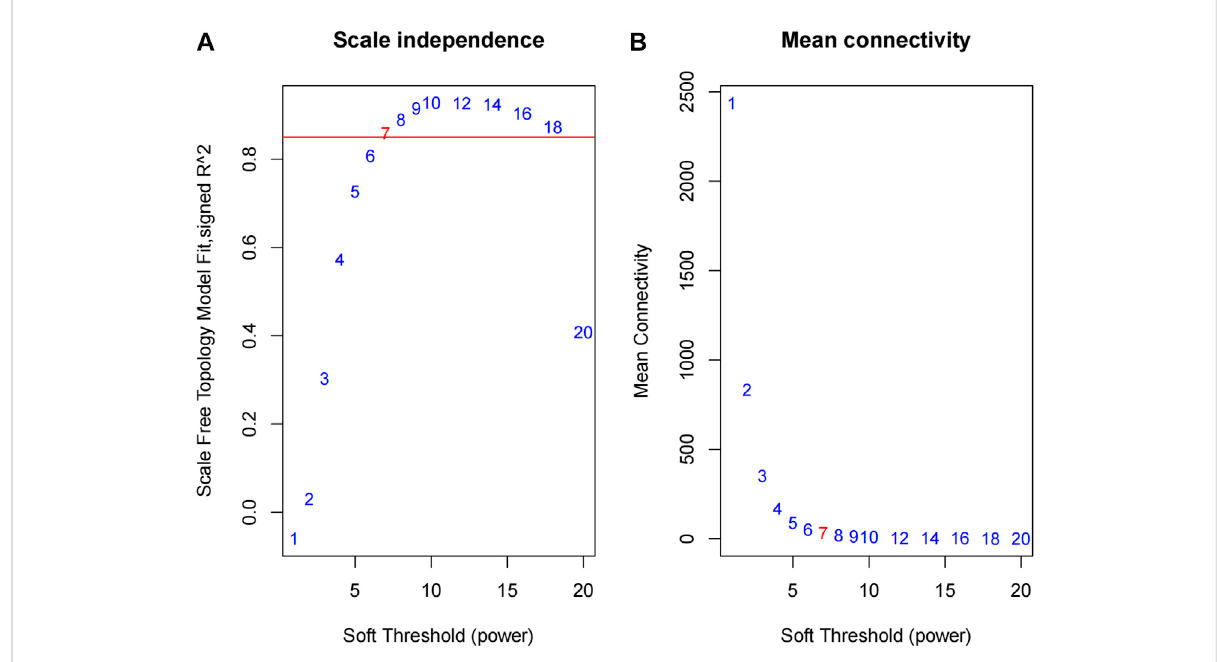
FIGURE 3 Determinationofthesoft-thresholdingpowerintheWGCNA. (A) Analysisofthescale-free fi tindexforvarioussoft-thresholdingpowers( β ). (B) Analysis of the mean connectivity for various soft-thresholding